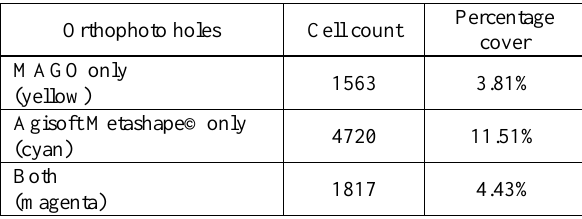
Table 1. Comparison between MAGO and Agisoft Metashape© orthophoto holes: cell count and percentage cover data.